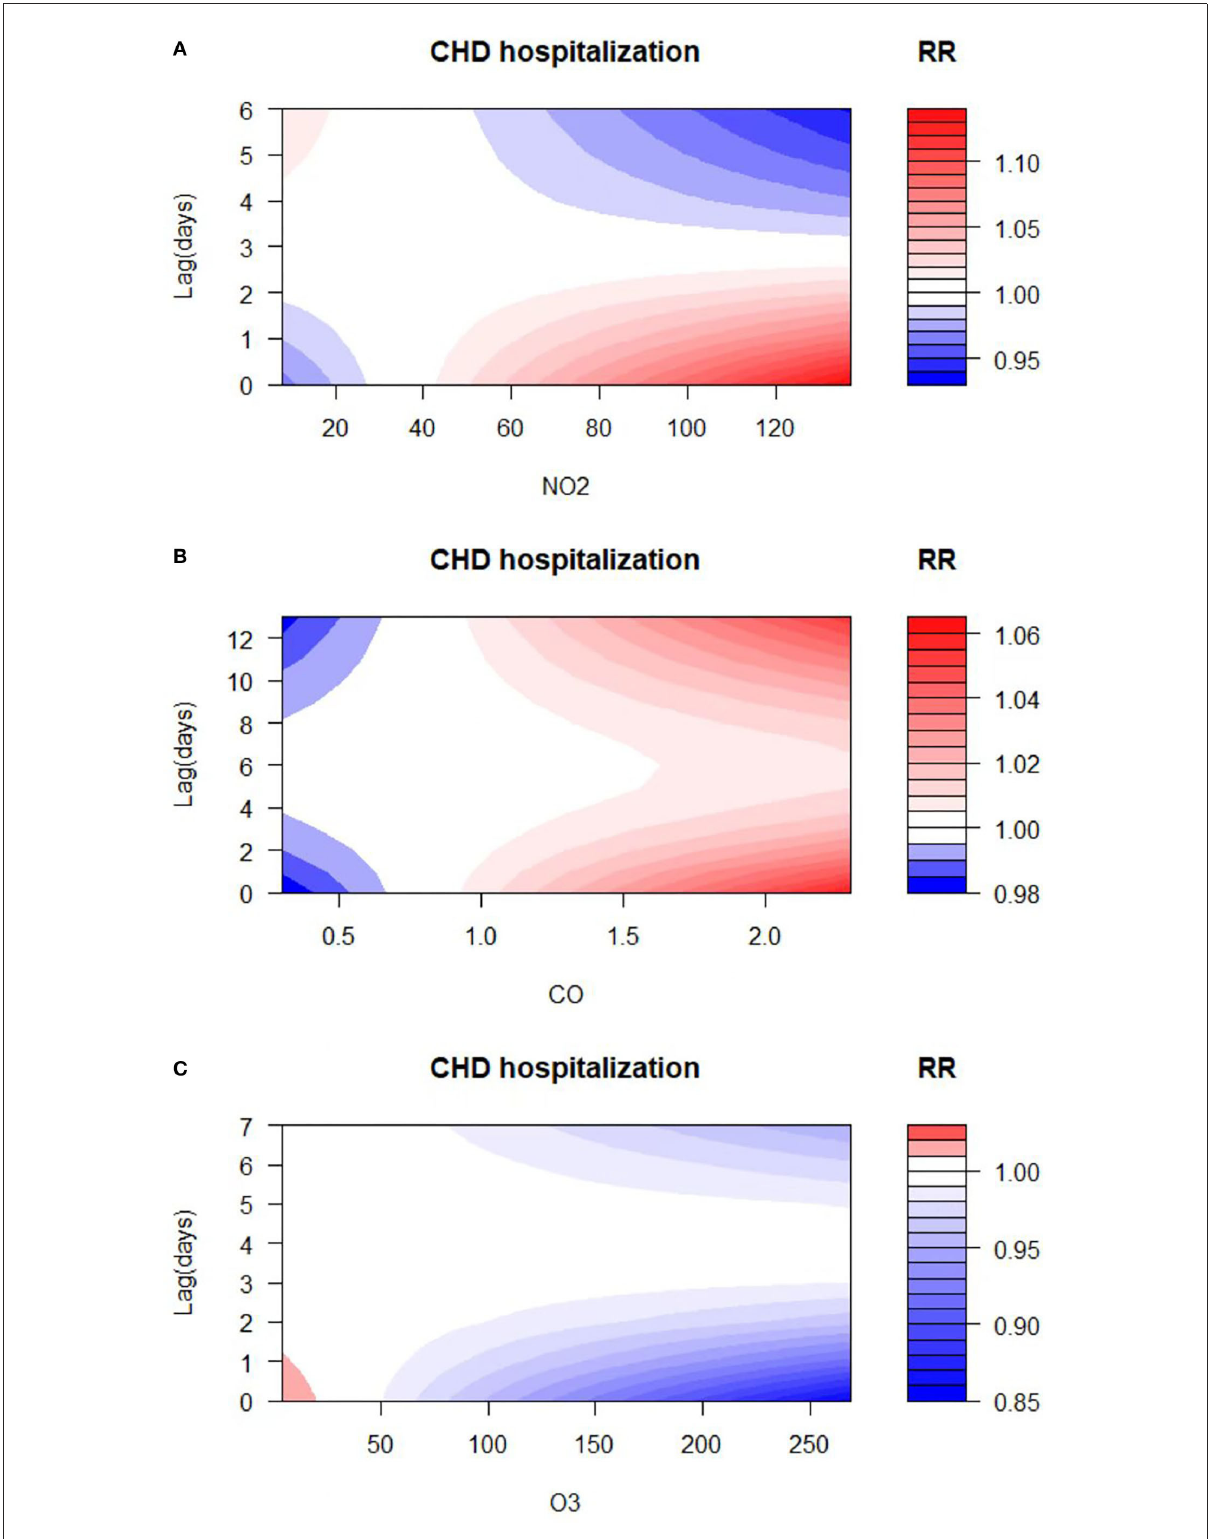
FIGURE4 Relative risk (RR) contour plots for CHD hospitalization during the lag periods of NO 2 (A) , CO (B) , and O 3 (C) in Hefei, China, 2014–2021.